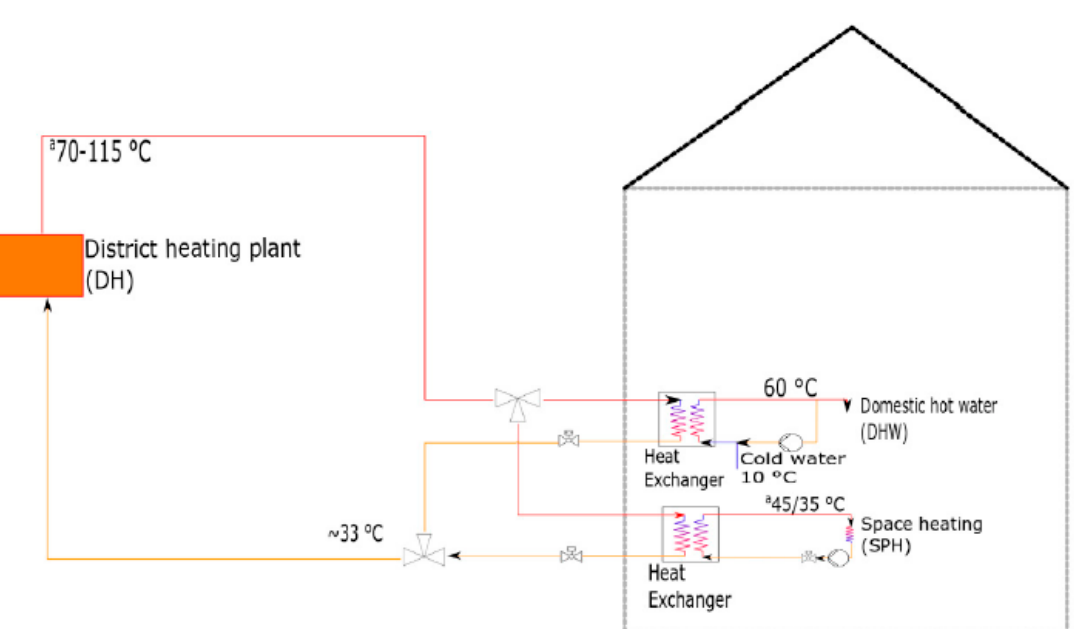
Figure 2. The schematic diagram of the reference old buildings integrated with city-level district heating (Case 0).